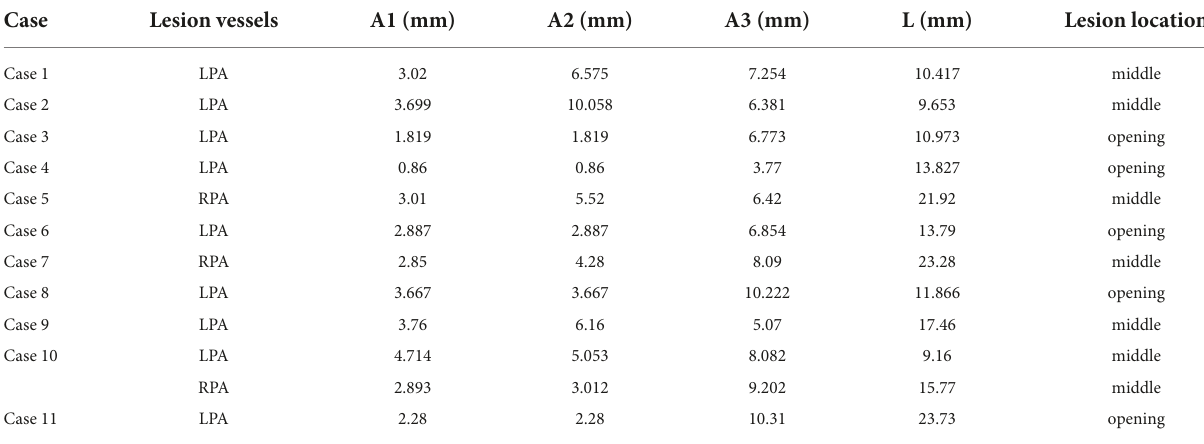
TABLE 2 256-slice scanner multiple-detector computed tomography (MDCT) parameters and morphological